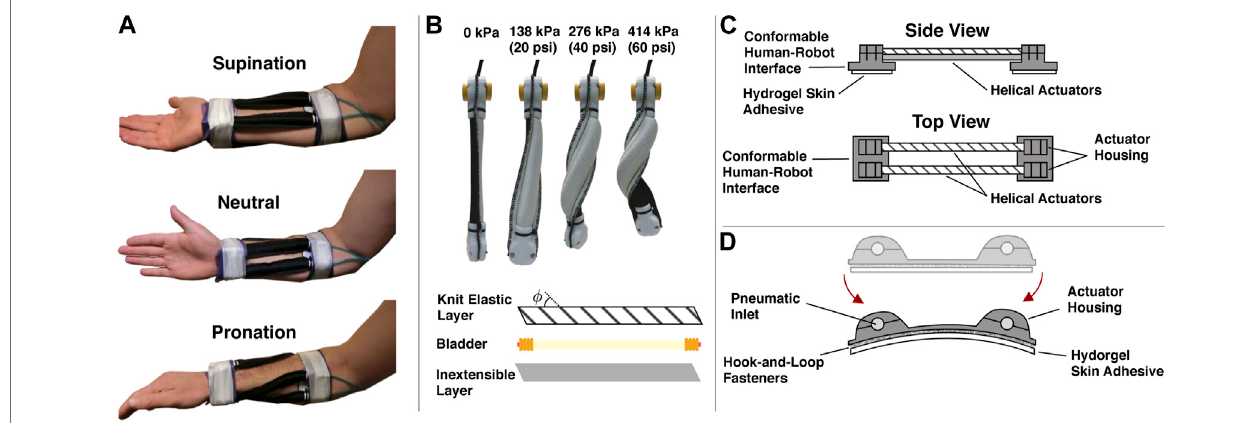
FIGURE 4 | The soft wearable robot hardware characteristics. (A) Medial view of the soft robotic orthosis during supination, neutral, and pronation con fi gurations. Twoantagonisticroboticorthosiselementsarewornbytheuseroneithersideoftheforearm.Theelementonthedorsalsideiscon fi guredtoprovideapronatingtorque, whilethe element onthe ventral side provides asupinating torque.Cohesivebandage(Coban) and medicaltape secure the human – robotic interface tothe human user. (B) In fl ationsequenceofasofthelicalactuatorandactuatorconstructiondetails.Aknitelasticfabriclayer(withknitangle ϕ )andaninextensiblefabriclayeraresewn together with a latex bladder enclosed. (C) Side and top view schematics of a one soft wearable robot module. A pair of helical actuators are attached at both ends to conformablehuman – robotinterfaces.Theconformablehuman – robotinterfacesinclude actuator housing sections thatfastenand securetheactuatorstotheinterfaces through cable ties (not shown). Removable hydrogel skin adhesives help attach the robotic orthosis to the human skin. (D) Conformable human – robot interface details. Theconformablehuman – robotinterfaceisdesignedtobendaroundandadheretohumans.Disposablehydrogeladhesivesareattached via hook-and-loopfastenersto the underside of the human – robot interface and adhere to the user ’ s skin reducing the relative motion between the human and